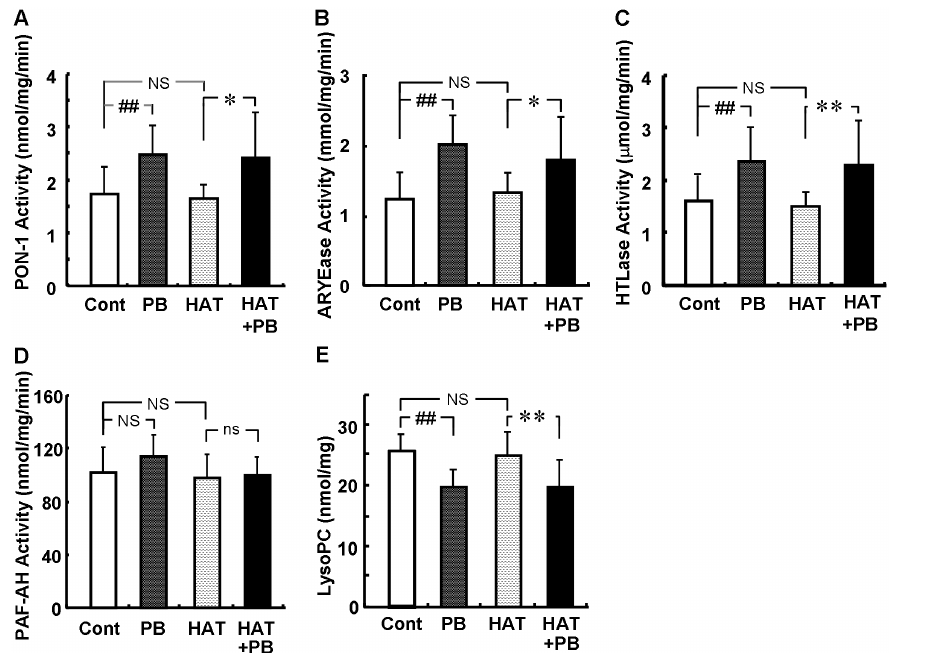
Figure 6. Effects of probucol on anti-oxidative enzyme activities in HDL. Effects on PON-1 (A), arylesterase (ARYEase) (B), homocysteine thiolactonase (HTLase) (C) and PAF-AH (D) activities, and LysoPC contents (E) in HDL at 6 weeks after administration. Data are presented as mean 6 SD. There were 11 animals in the control (Cont) and 0.1% probucol (PB) groups, and 12 in the 0.003% atorvastatin (HAT) and HAT + PB groups. *p , 0.05; **p , 0.01 by unpaired t-test. ## p , 0.01; NS, not significant by Dunnett’s test.